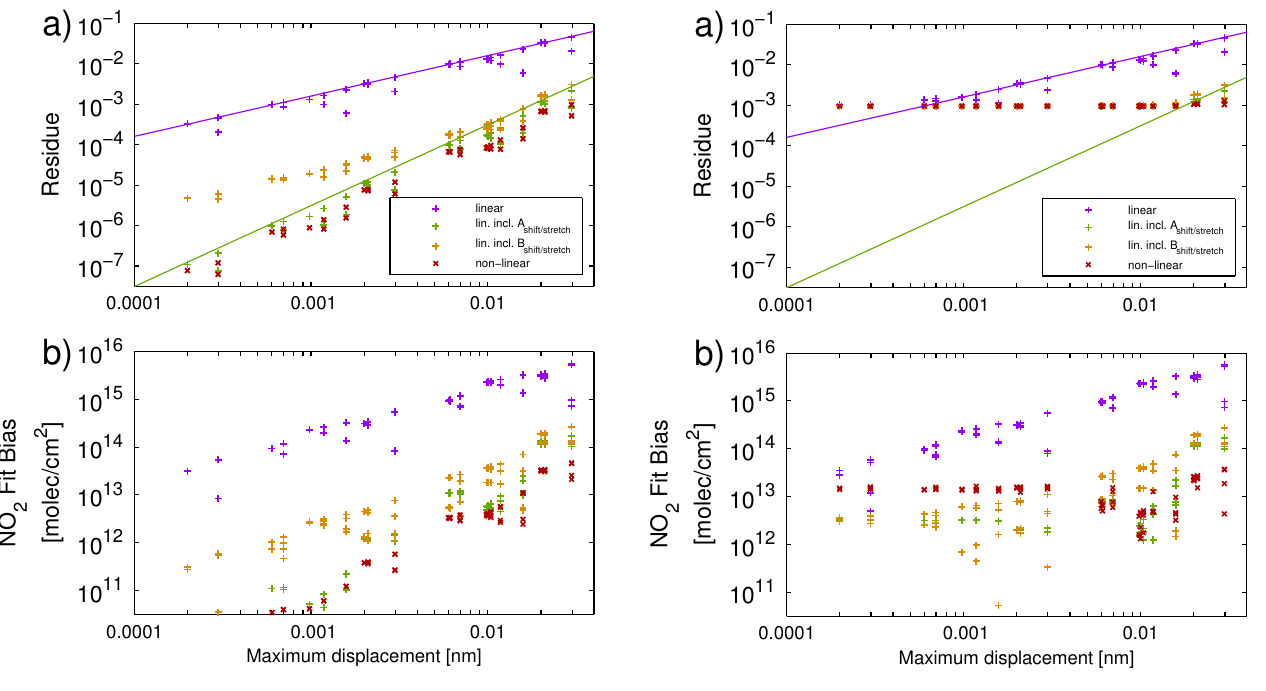
Fig. 6. As Fig. 5 for synthetic radiances with additional Gaussian noise of